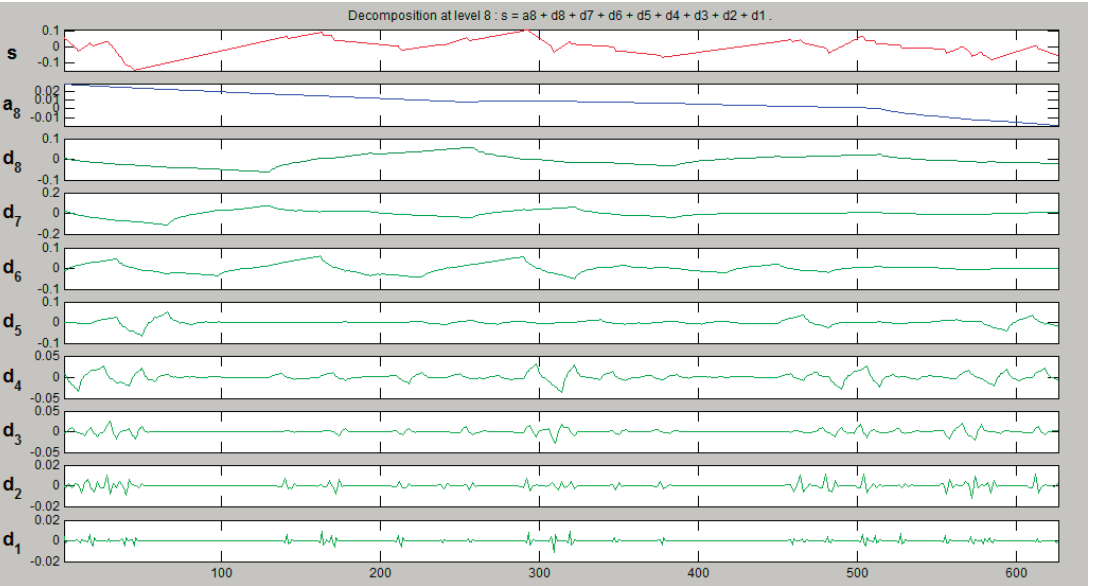
Figure 15. ALS signal decompositions with wavelet “db2”, eight